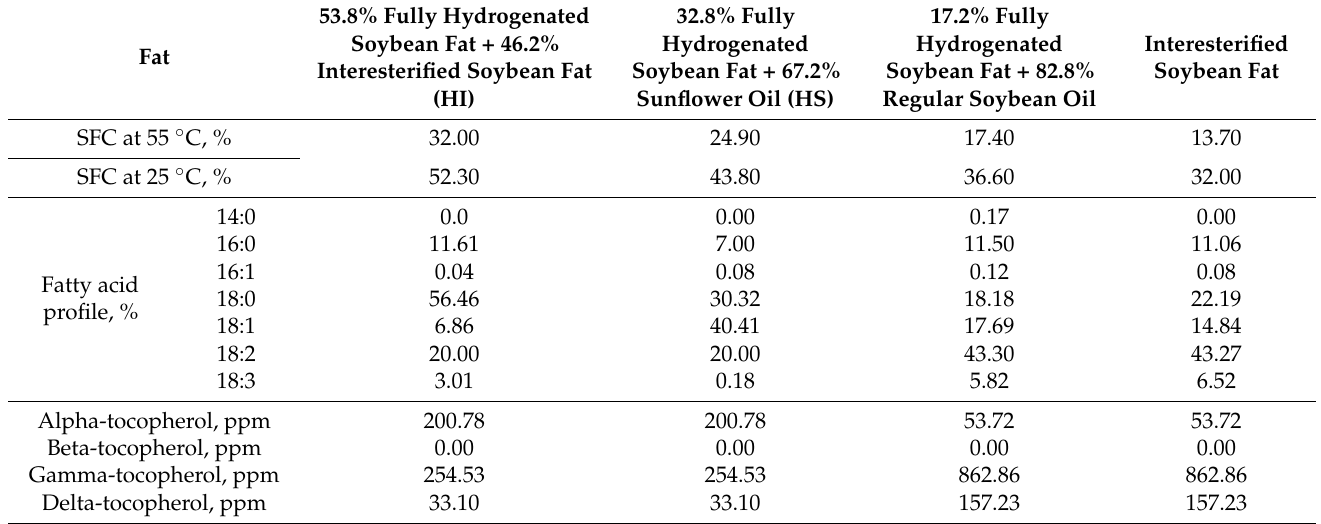
Table 1. Solid fat content (SFC), fatty acid profile, and tocopherol profile of a series of two fat blends and a comparison of fat blends and interesterified fat that were used to make the